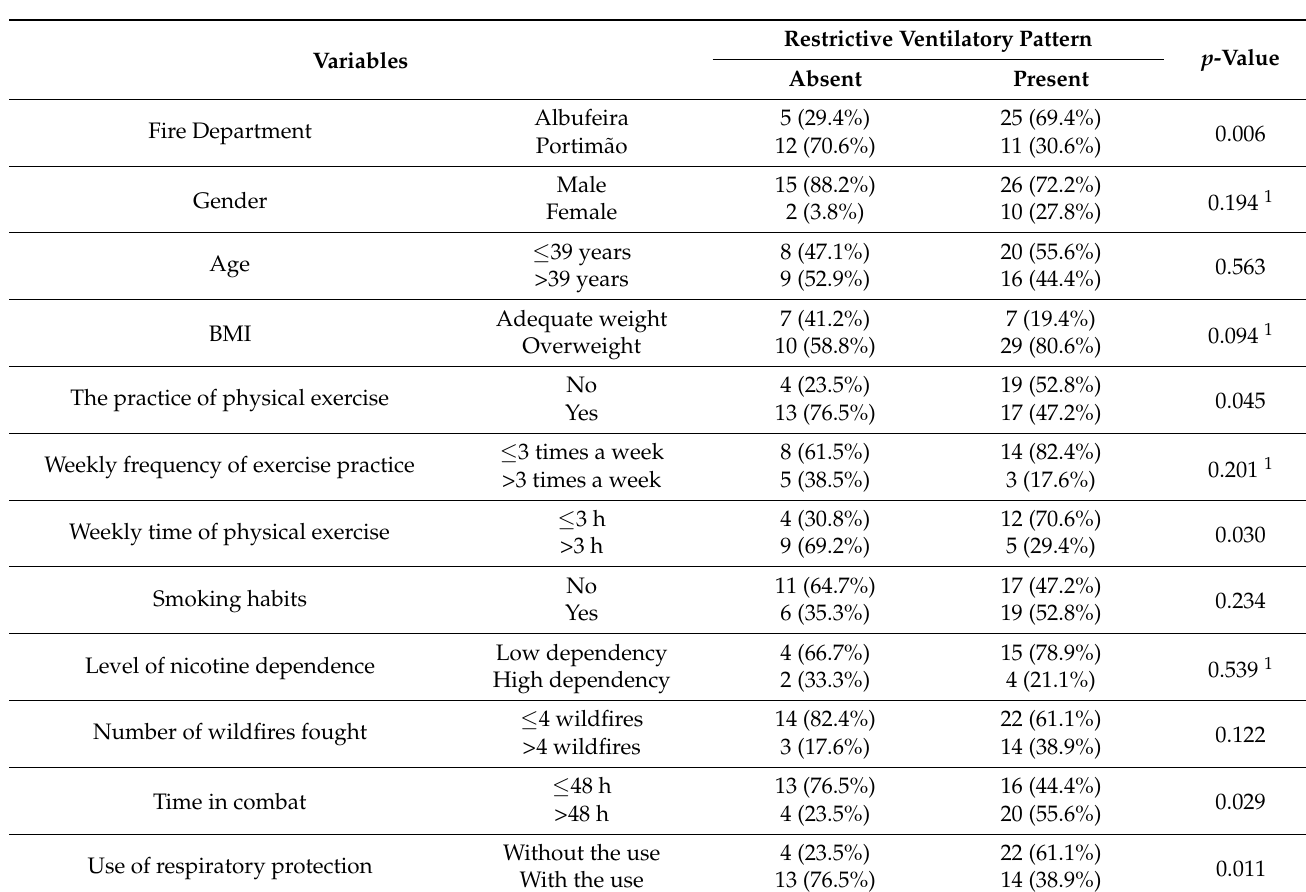
Table 4. Association between variables and the ventilatory pattern.